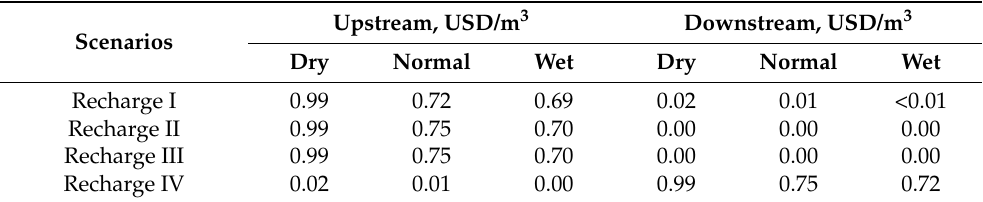
Table 5. The annual average economic value of conveyance infrastructure expansions upstream and downstream as shadow values of upper bound constraints on conveyance links.